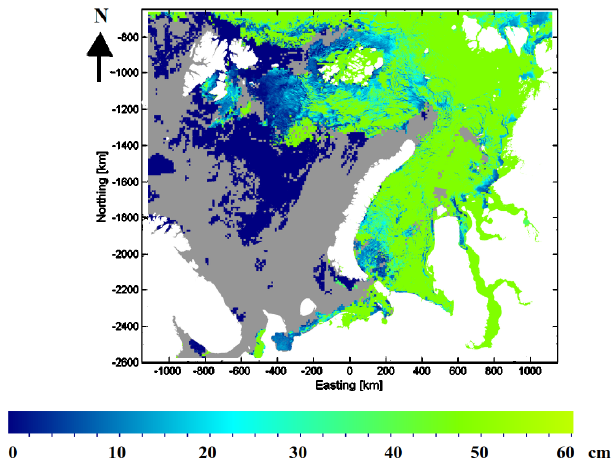
Figure 13. MODIS SIT collage based on 2 weeks of MODIS daily SIT charts before 21 February 2017. The areas without data are in- dicated by the grey colour, and all the ice thicker than 50cm is in- dicated by the green colour, corresponding to 60cm in the colour